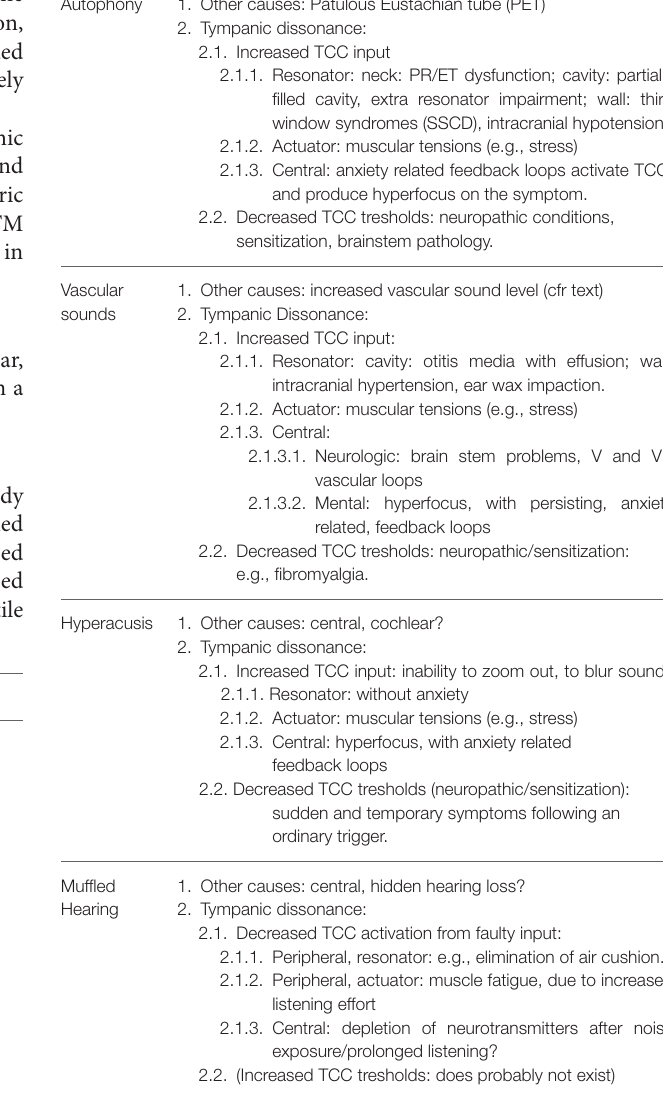
TABLE 3 | Auditory